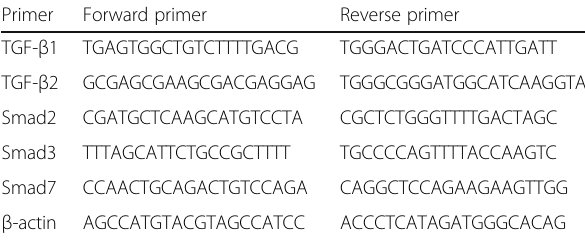
Table 1 Primers used for qPCR analysis Primer Forward